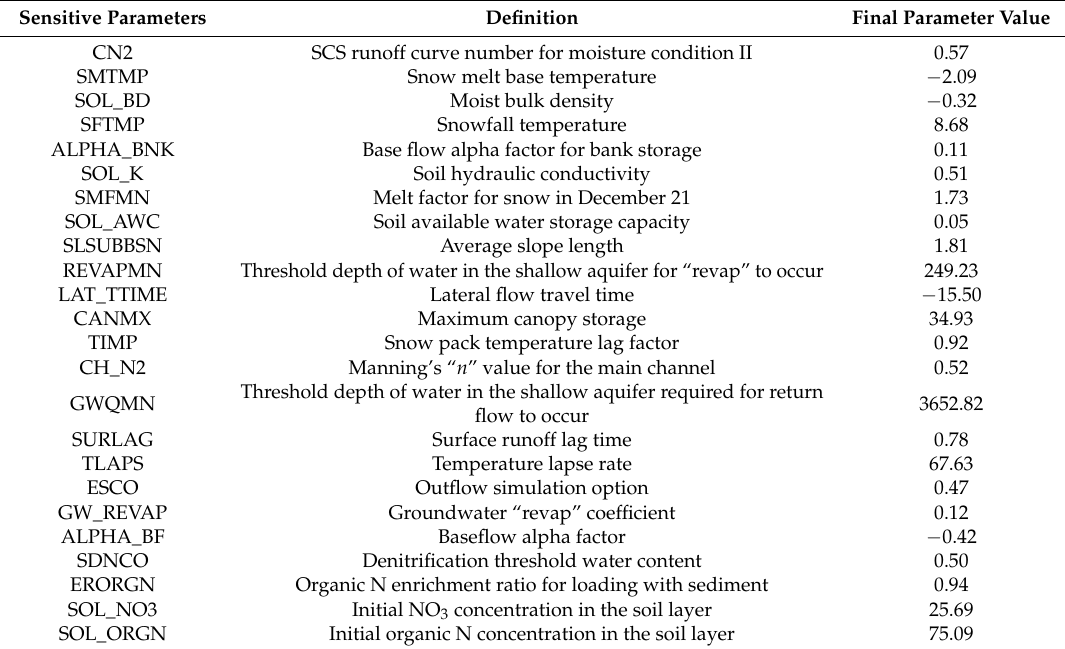
Table 7. SWAT parameters that were fitted and their final calibrated values.